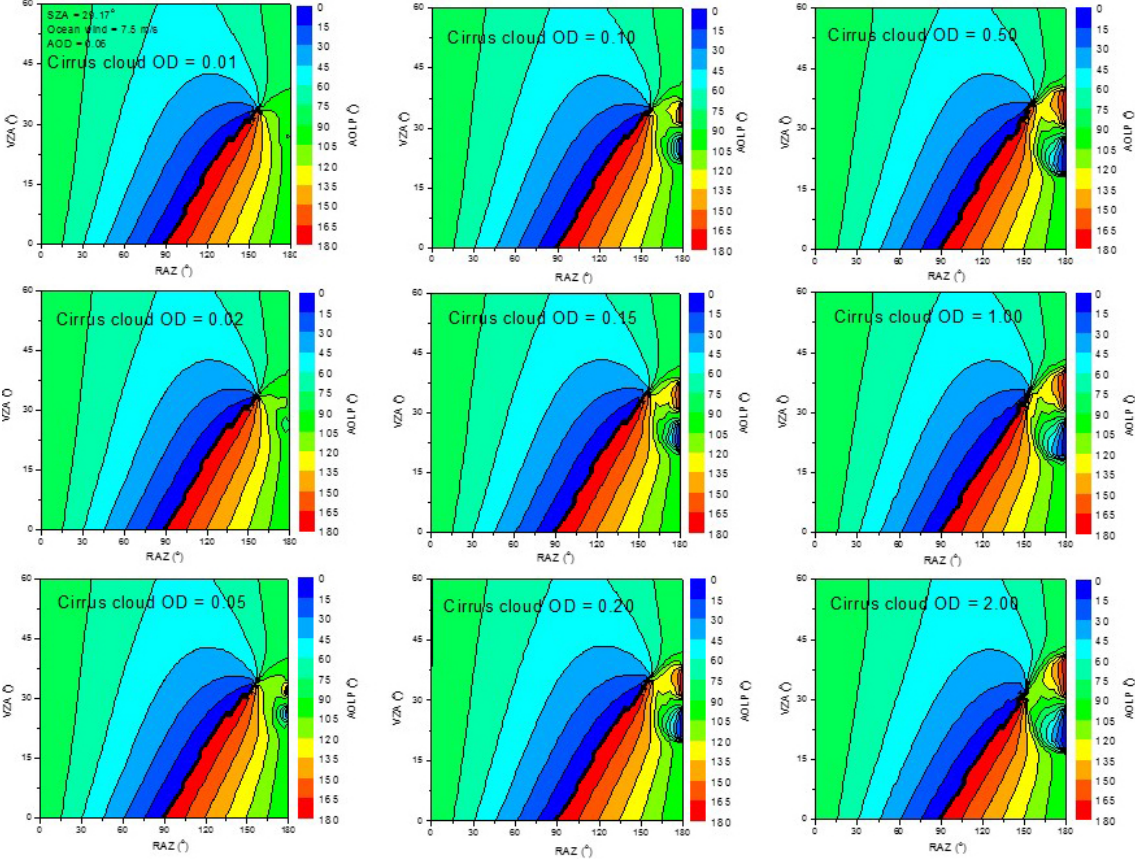
Figure 3. The modeled AOLP of reflected sunlight at a wavelength of 670nm from cirrus clouds (complex particle shapes). In the ADRTM modeling, the clouds’ optical depths (OD) are set from 0.01 to 2.0, the ocean wind speed is assumed to be 7.5ms − 1 , the solar zenith angle (SZA) is 29.17 ◦ , and the aerosol optical depth (AOD) is 0.06. The size distribution of the ice particles in the cirrus clouds is from Heymsfield and Platt (1984) for the cloud temperature of − 20 to − 25 ◦ C. The cirrus clouds are assumed to be composed of a mixture of complex particle shapes for tropical cirrus clouds as described in Meyer et al. (2004). Cirrus clouds composed of complex particle shapes crystals exhibit the p -polarization feature when their OD is >0.06.